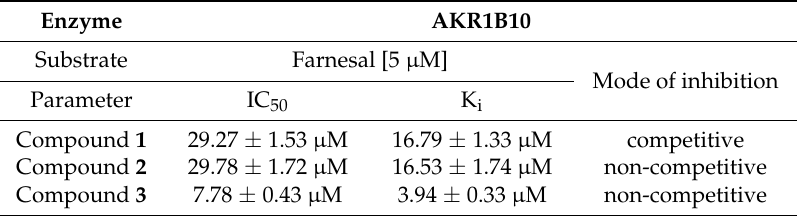
Table 4. IC 50 and K i values of AKR1B10 mediated farnesal reduction with isolated hop-compounds. IC 50 and K i values are presented as mean ± SD of at least three